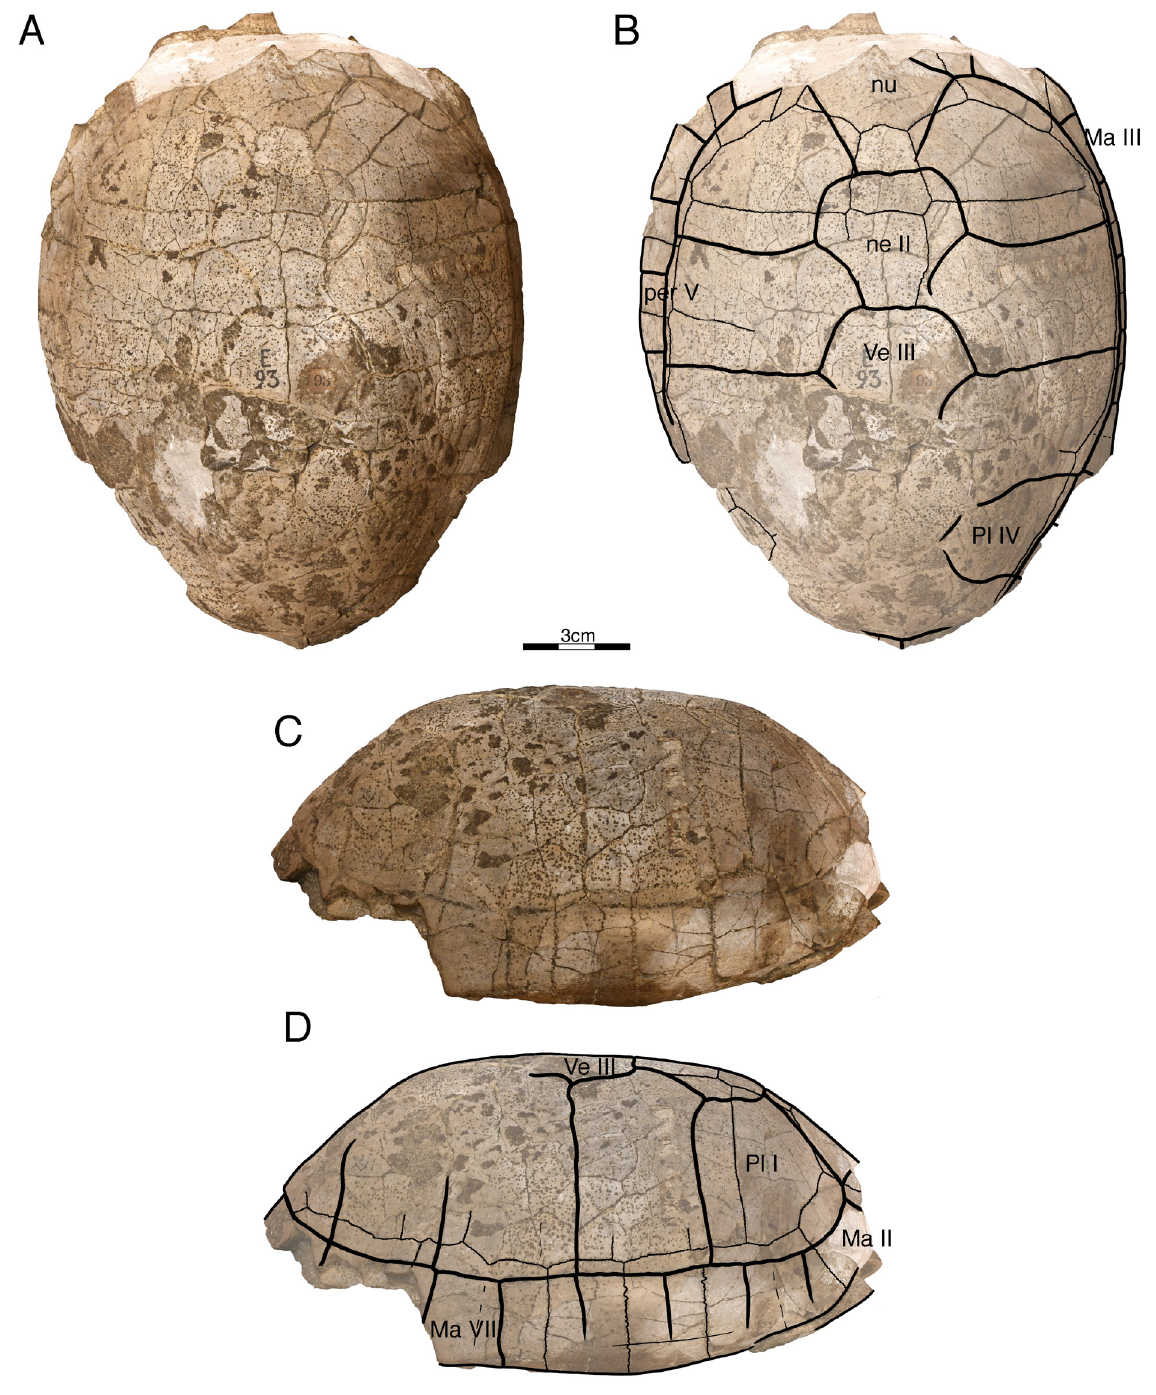
Fig. 31. IM E.93, holotype of Clemmys hydaspica Lydekker, 1885, here identified as Melanochelys sivalensis (Theobald, 1877) comb. nov. A . Photograph of carapace. B . Illustration of carapace. C . Photograph of carapace in lateral view. D . Illustration of carapace in lateral view. Scale bar: 3